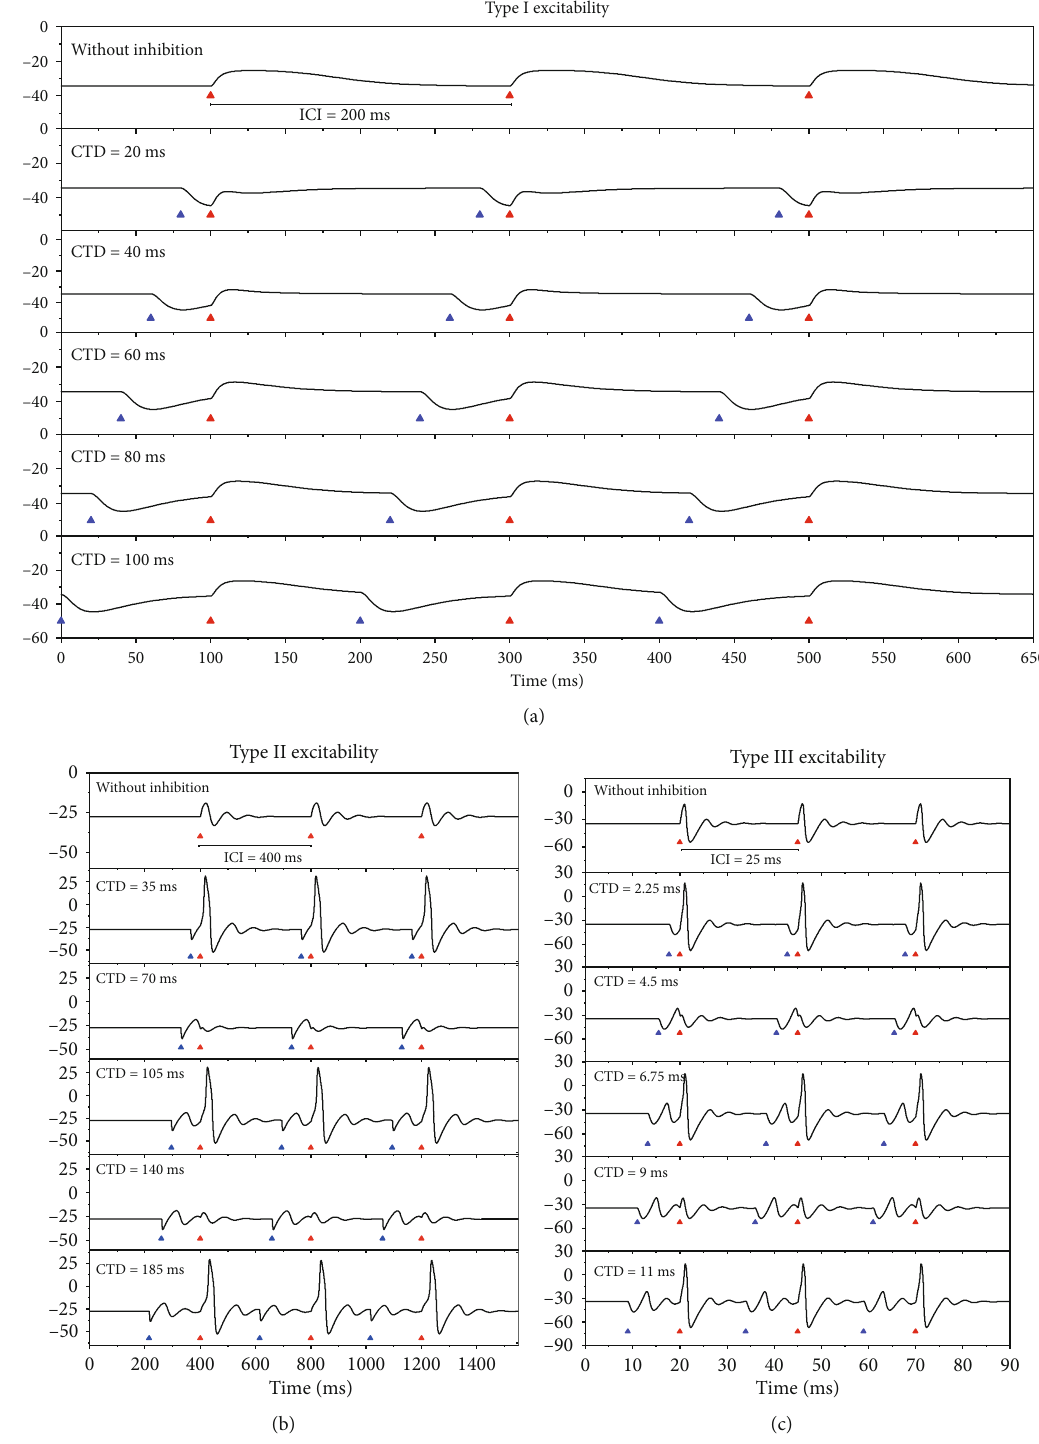
Figure 2: The responses of the membrane potentials to the stimulation pairs of the inhibition (blue triangles) and excitation (red triangles) for the three types of excitability. (a) Type I excitability. The ICI is fi xed at 200 ms and G ex = 1 : 1 mS/cm 2 . G inh = 0 mS/cm 2 for the fi rst panel, and the CTDs are 20, 40, 60, 80, and 100ms from the 2nd to the last rows, respectively, and G inh = 0 : 8 mS/cm 2 . (b) Type II excitability. The ICI is fi xed 400ms and G = 1 : 1 mS/cm 2 . G = 0 mS/cm 2 for the fi rst panel, and the CTDs are 35, 70, 105, 140, and 185ms from the 2nd to the last ex inh rows, respectively, and G inh = 3 : 1 mS/cm 2 . The PIF phenomenon appears in the 2nd, 4th, and last panels. (c) Type III excitability. The ICI is 25ms and G ex = 3 mS/cm 2 . G inh = 0 mS/cm 2 for the fi rst panel, and CTDs are 2.25, 4.5, 6.75, 9, and 11ms from the 2nd to the last rows, respectively, and G inh = 1 : 1 mS/cm 2 . The PIF phenomenon appears in the 2nd, 4th, and last panels. The fi gures show the fi rst three pairs of the